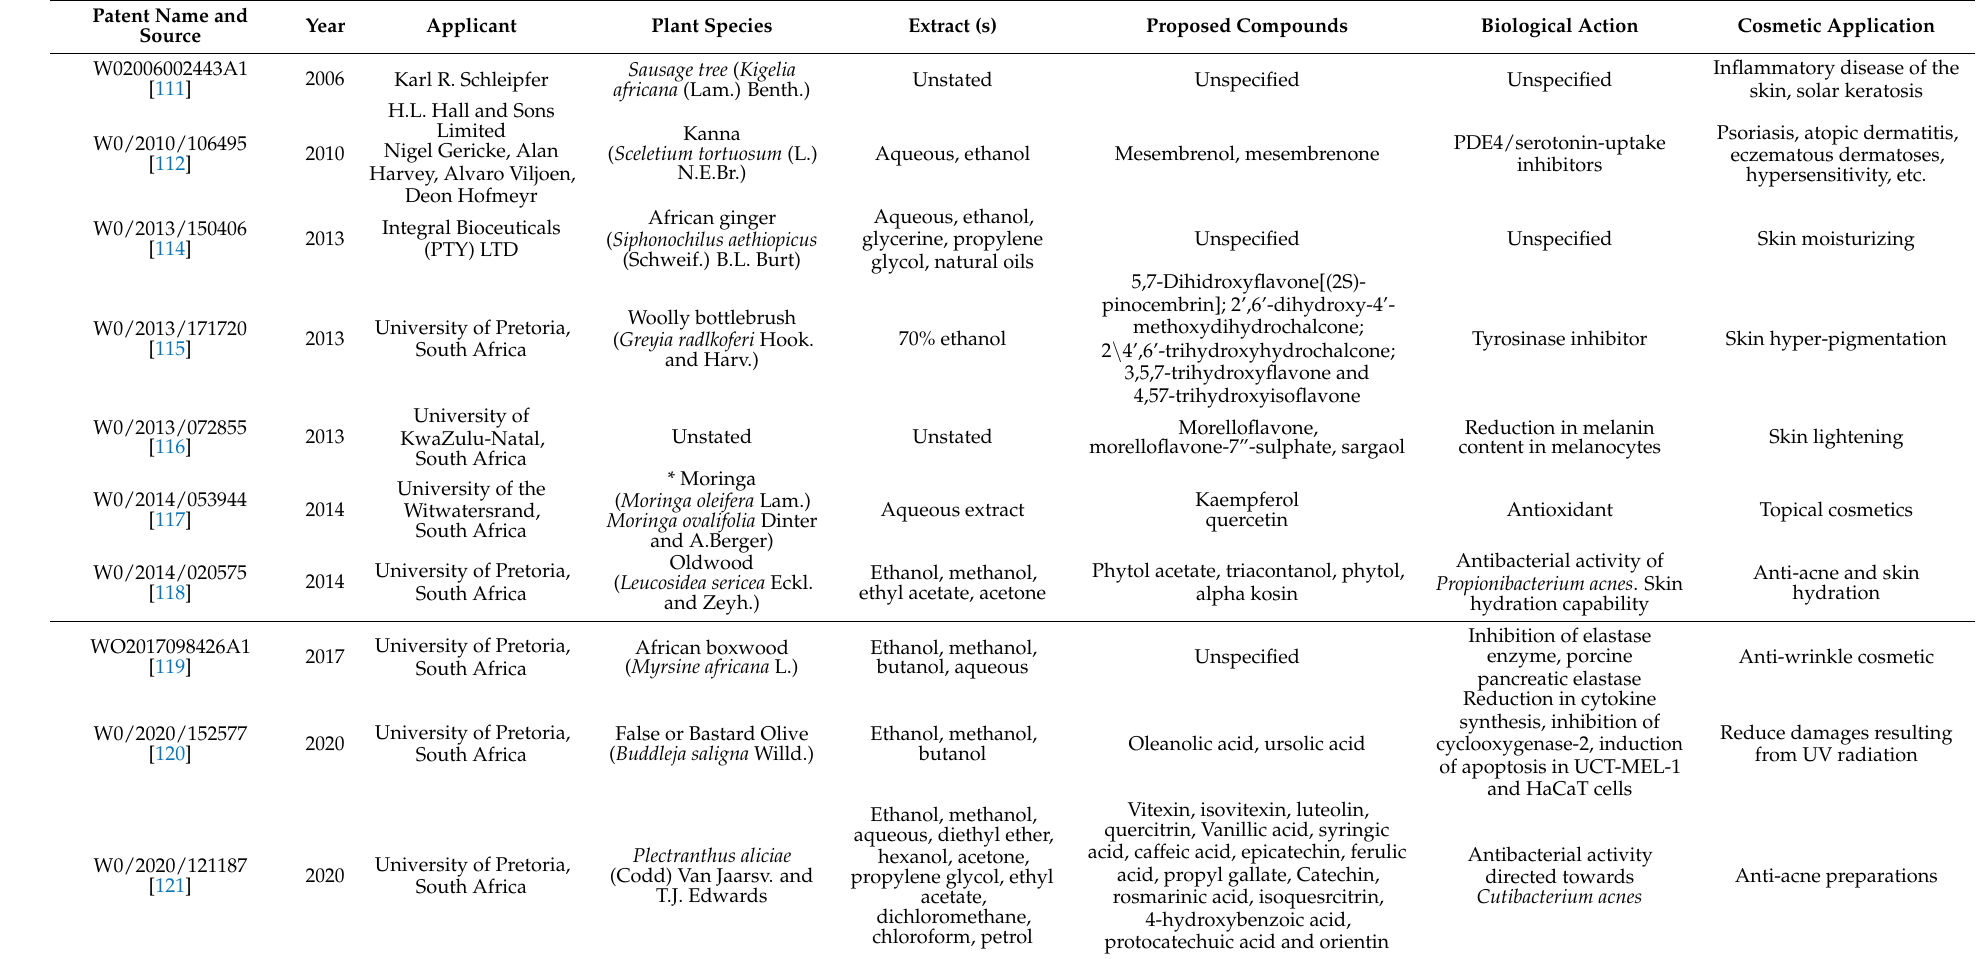
Table 4. South African endemic botanical extracts and processes patented for use in the cosmeceutical